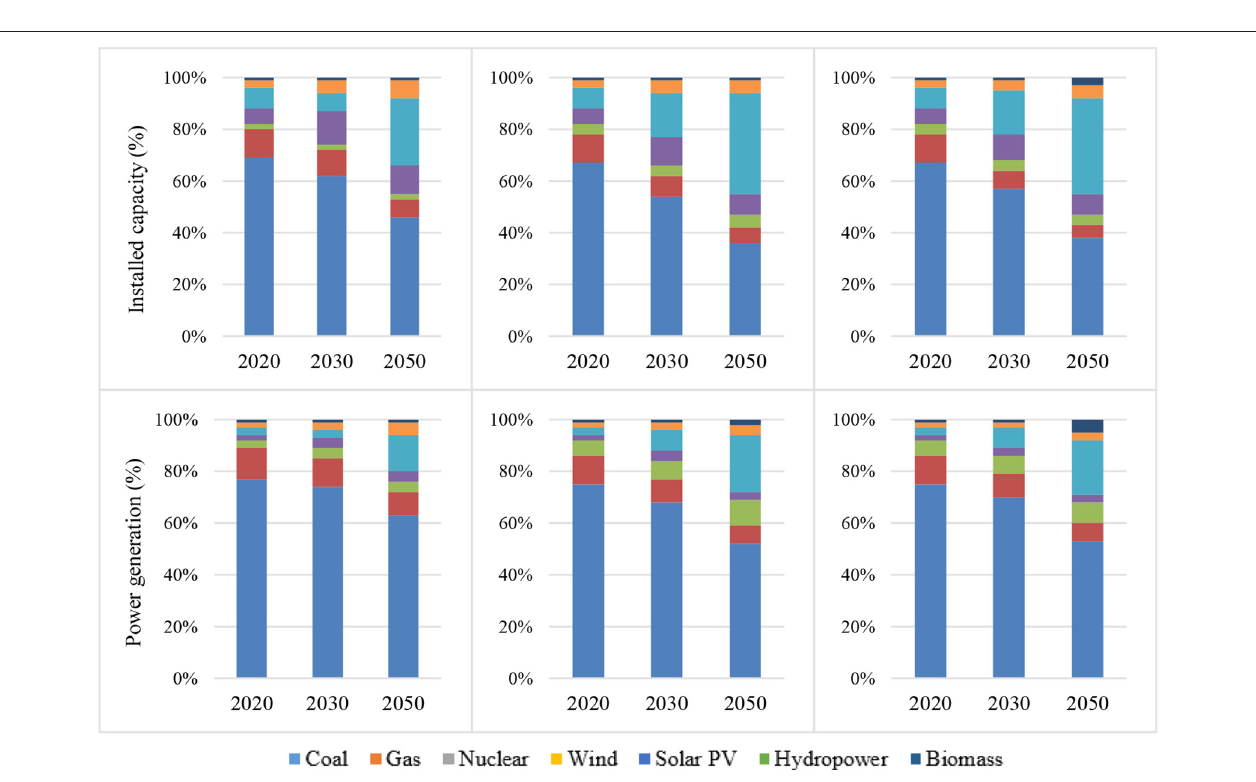
Frontiers in Energy Research |